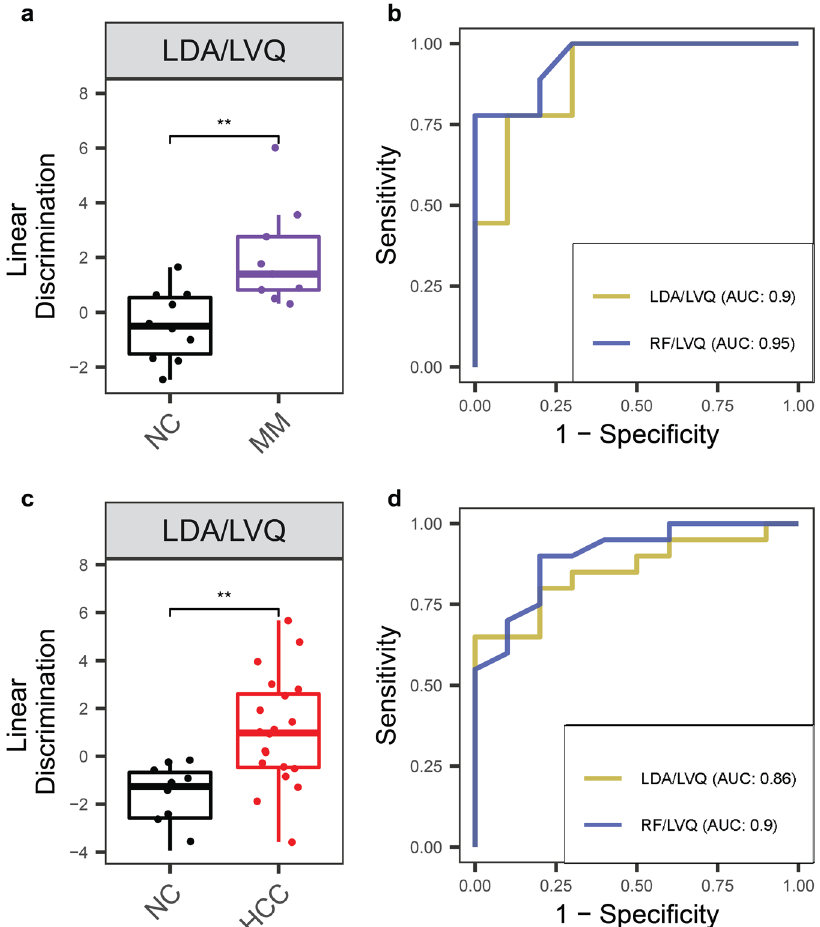
Fig. 5 cfRNA biomarkers and classi fi cation models validated in independent sample set. a , c Linear discriminant analysis in the validation cohort using top ten LVQ genes identi fi ed and classi fi cation models trained on the pilot cohort for MM versus NC, and HCC versus NC. P value was calculated for each pair by the Wilcoxon rank-sum test. Center-line indicates the median value across all patients in that group, and the hinges represent the lower (Q1) and upper (Q3) quartile, with whiskers extending to the minimum and maximum of the resulting distribution. b , d ROC curves of these same classi fi cation models, trained on the pilot sample set and tested with the validation sample set, using the top ten LVQ genes identi fi ed from the pilot sample